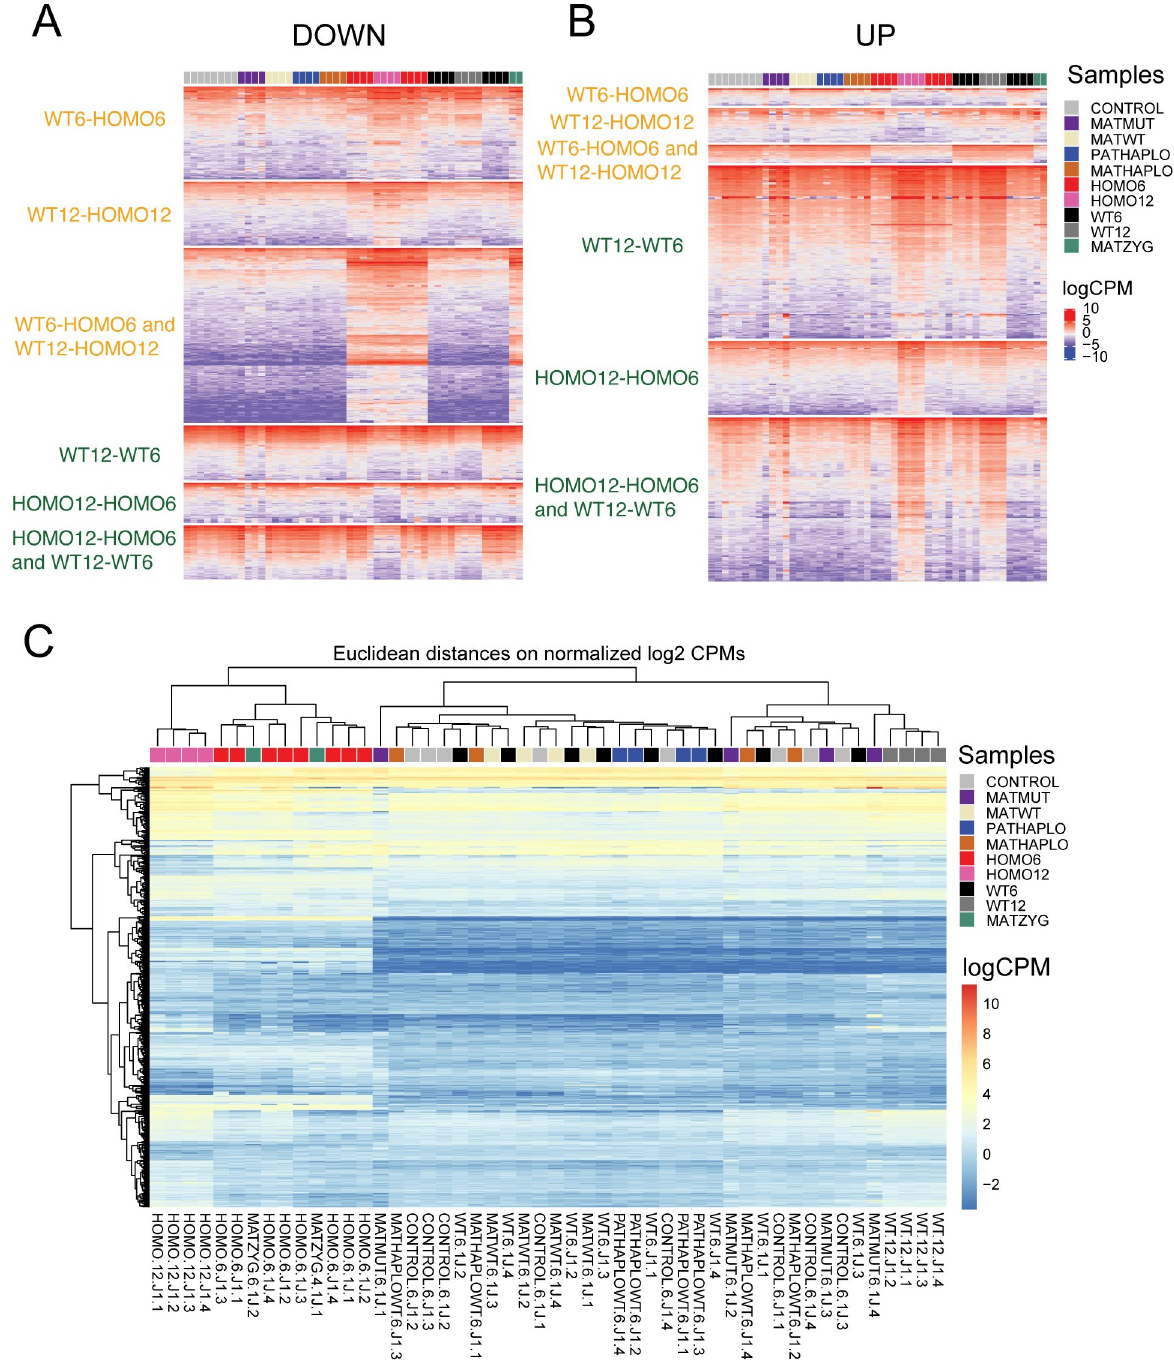
Fig 5. Transcriptomes of embryos with different Ehmt2 genetic deficiencies. Heatmaps display gene expression values (logCPM) for the downregulated ( A ) and upregulated ( B ) genes from the compartments of the Venn diagrams in Fig 3D and 3E, as marked, representing the full dataset (Fig 1A and S2 Table). Four replicates are shown in the samples coded by color (to the right). ( C ) Heatmap displays the results of an unsupervised cluster analysis that calculates Eucledian distance between samples based on the DE genes identified in the four-way comparison displayed in the Venn diagrams in Fig 3D and